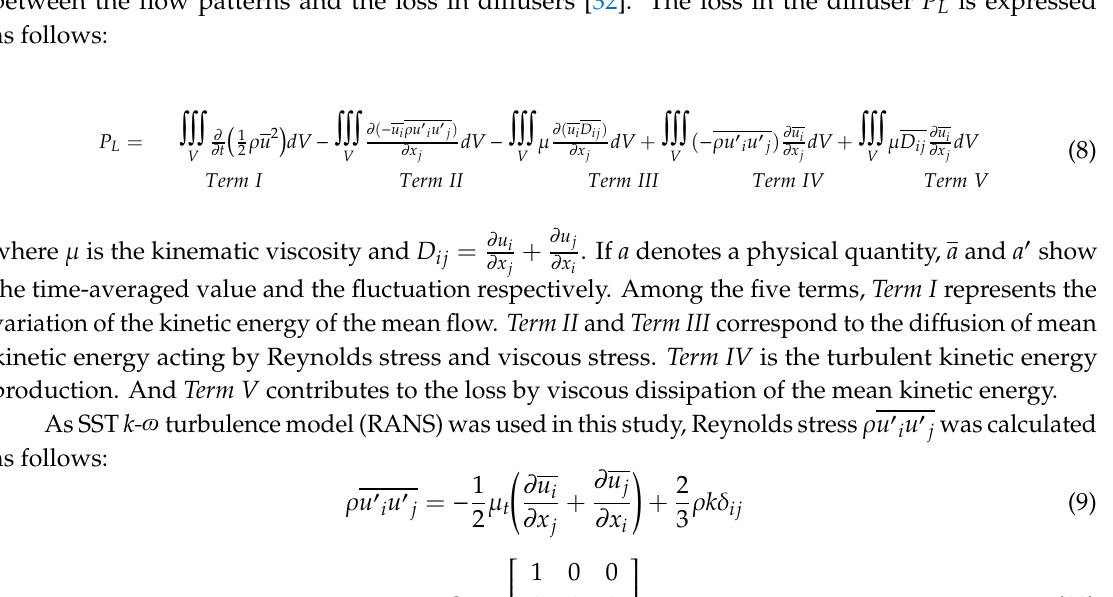
Table 1. Major dimensions of test diffuser and vane.